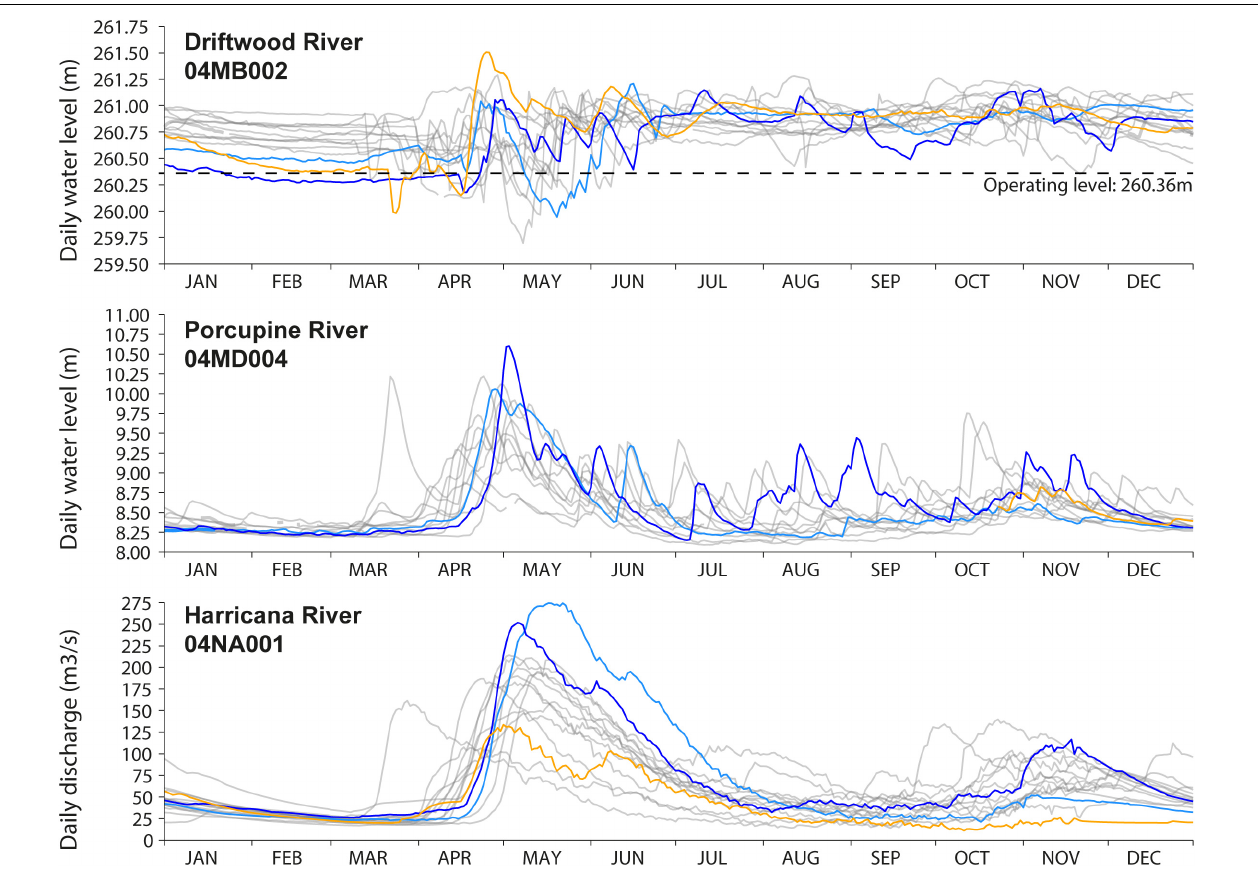
FIGURE 3 | Comparison of the daily water level of the Driftwood River downstream of the Monteith dam (2006–2020) with the daily water levels of the unregulated Porcupine River at Hoyle ( ∼ 50 km west; 2007–2019) and the daily discharge of the unregulated Harricana River at Amos ( ∼ 200 km east; 2006–2020). Daily data for the year 2007 are incomplete at the Porcupine River gage station. Data were extracted from the historical hydrological station data of the Water Survey Canada. The years of maximum discharge or water level found during the 2006–2020 period and in the three rivers are highlighted in color. The light blue line represents the year 2019 (maximum discharge in the Harricana River), the dark blue line represents the year 2013 (maximum water level found in the Porcupine River), and the orange line represents the year 2007 (maximum level found in the Driftwood River). The dashed line in the upper panel depict the operating level (260.36 m) of the Monteith